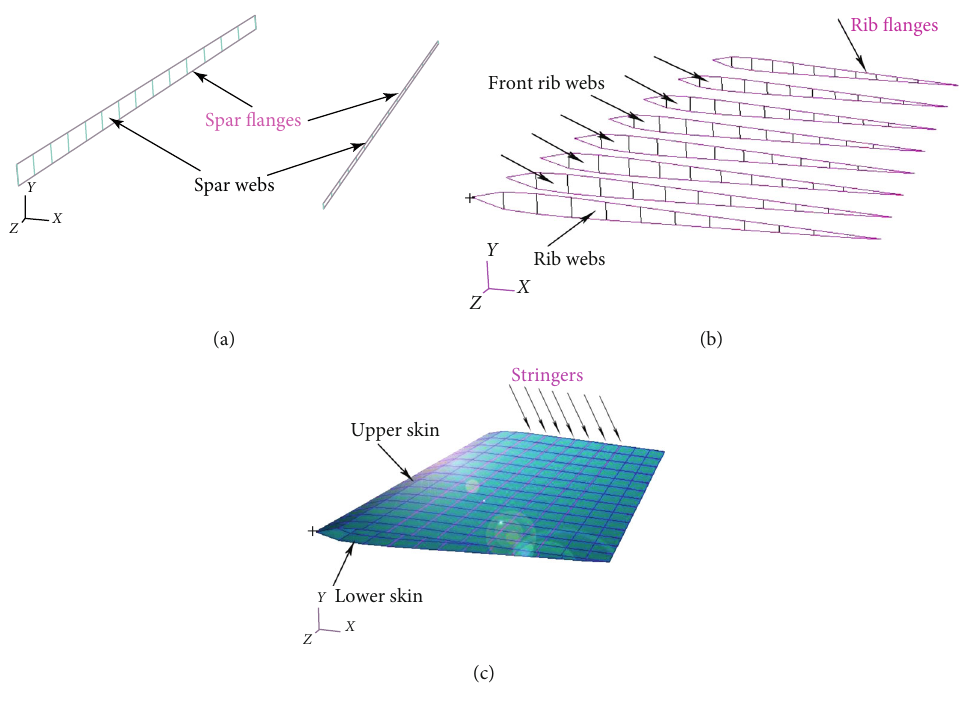
Figure 2: FEM of the wing (a –